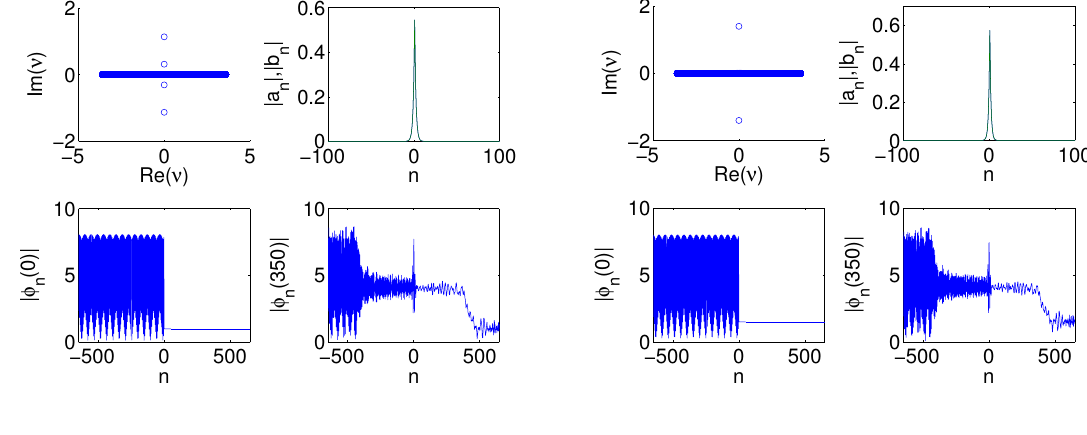
Figure 4. Here we focus on parameter values that correspond to a bright region in the left panel of Figure 2. We show four plots similar to the right panel of Figure 2. Here we have N = 1 , L = 1299 and k = 2 . 5 . The left panel of four plots corresponds to γ = 9 . 5 , T = 1 , 1 = 10 , T = 1 . 5 . Comparing the three sets of four plots and the right panel corresponds to γ 1 in the present figure and in Figure 2 shows the transition in the eigenvalue plots as we move towards brighter regions of the | min(Im( ν ) | diagram.